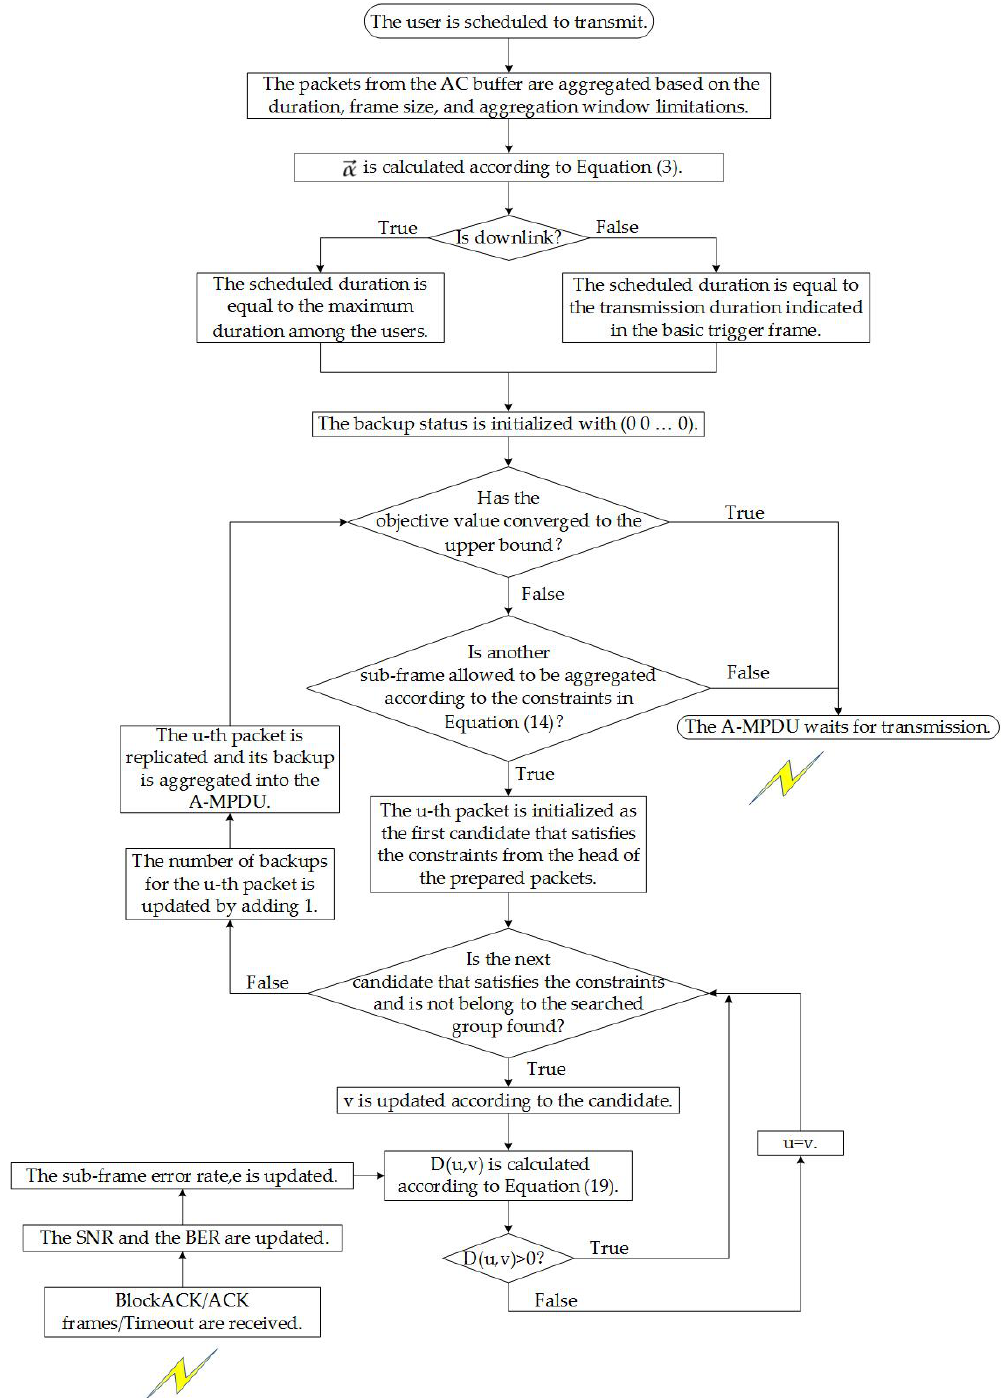
Figure 10. The procedure of the BP-ARQ